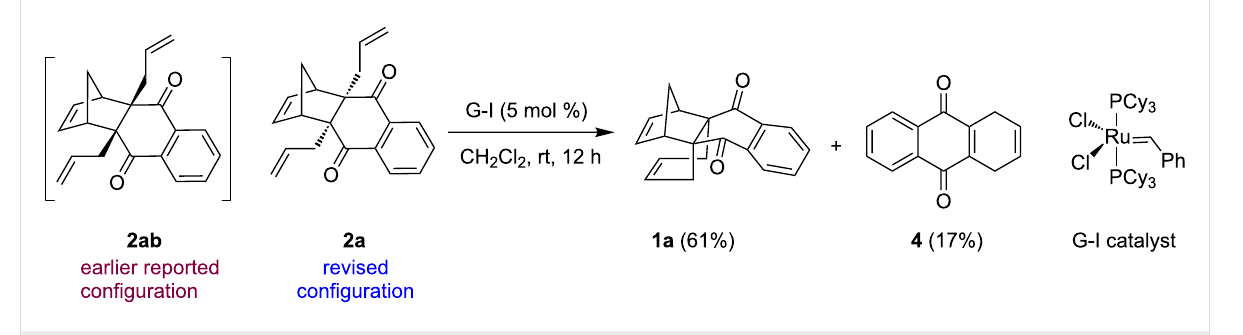
Scheme 1: Synthesis of the propellane derivative 1a via